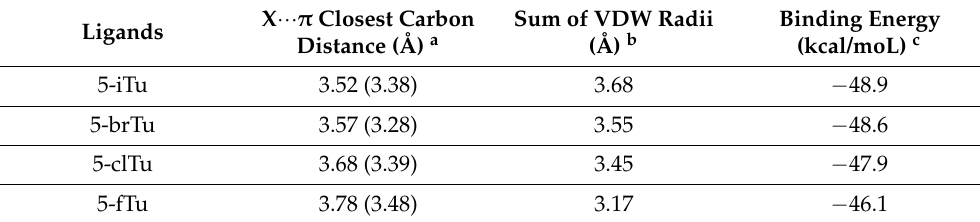
Figure 3. Key interaction sites of tubercidin inhibitors with Haspin from MD simulations. Interaction distance (Å) between halogen atom and C α carbon of Phe605 phenyl ring: ( a ) 5-fTU, ( b ) 5-clTU, ( c ) 5-brTU and ( d ) 5-iTU. The geometries were chosen by the shortest distance from the last 50 snapshots for each MD trajectory. Table 1. Halogen bond distances and binding energies of halogenated tubercidin ligands with Haspin receptor obtained from MD simulations.